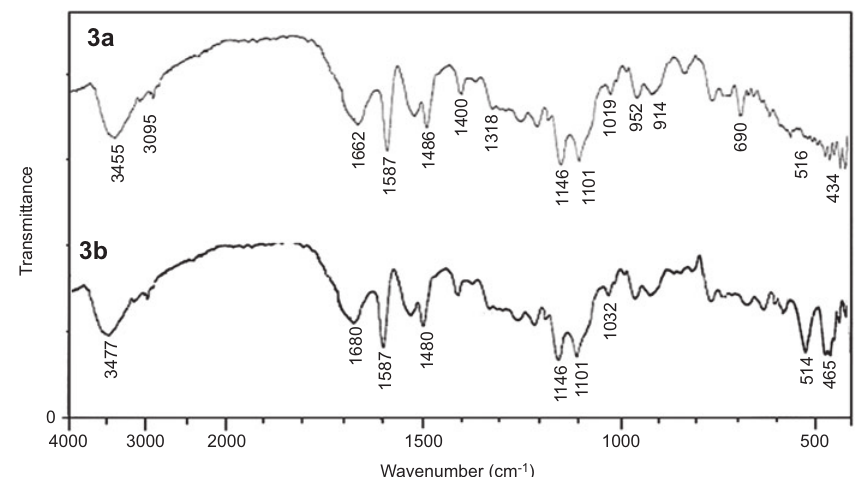
Figure 1 FT-IR spectra of PA-nanocomposite fi lms 3a and 3b